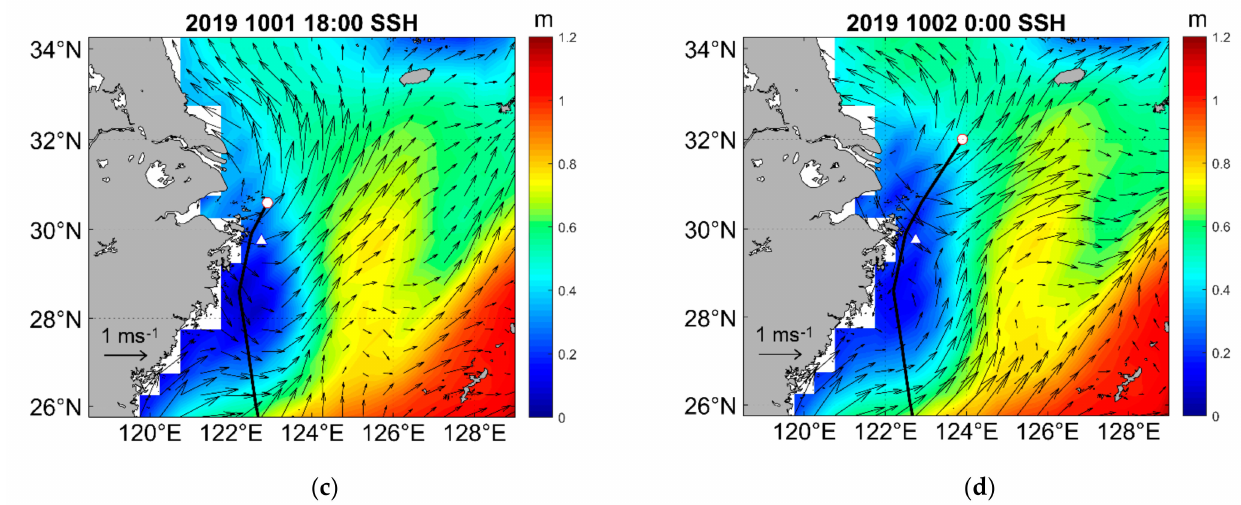
Figure 10. The sea surface height (SSH) and currents at a different time. ( a ) 18:00 on 30 September. ( b ) 0:00 on 1 October. ( c ) 18:00 on 1 October. ( d ) 0:00 on 2 October. (The vectors represent currents, the black line is “MITAG” track, circle is typhoon center, and the triangle is location of Zhoushan buoy.)